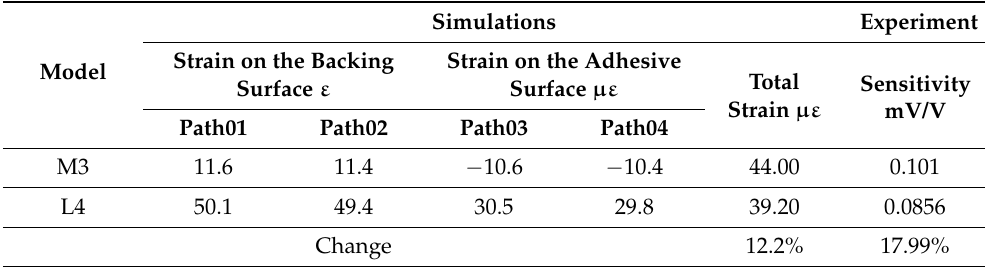
Figure 4. ( a ) Sensor resistance drift during the fatigue test; ( b ) strain distribution curves for the M3 and L4 sensitive grids. Table 3. Comparative total strain output and sensitivity of M3 and L4 regarding the simulations and experimental test, respectively.